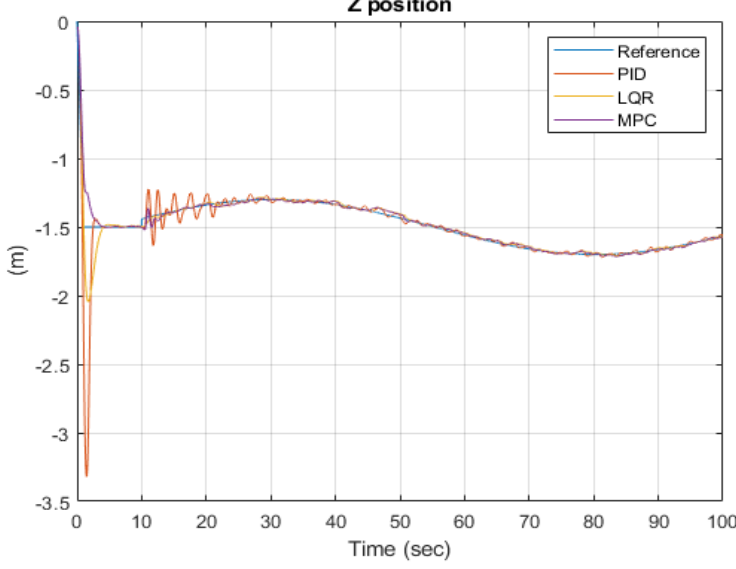
Figure 6. Performance of the controllers along z axis in simulation.